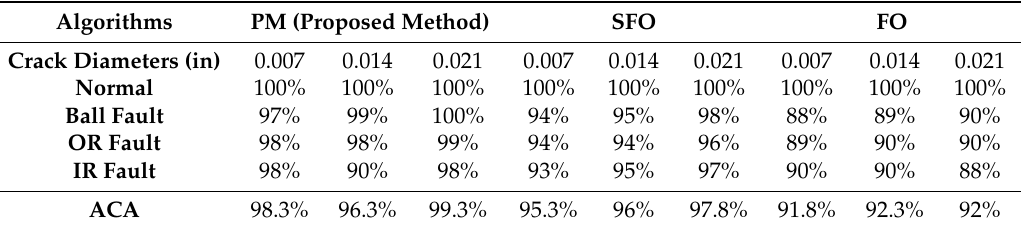
Table 4. The single fault diagnosis accuracy for 1 hp torque load.